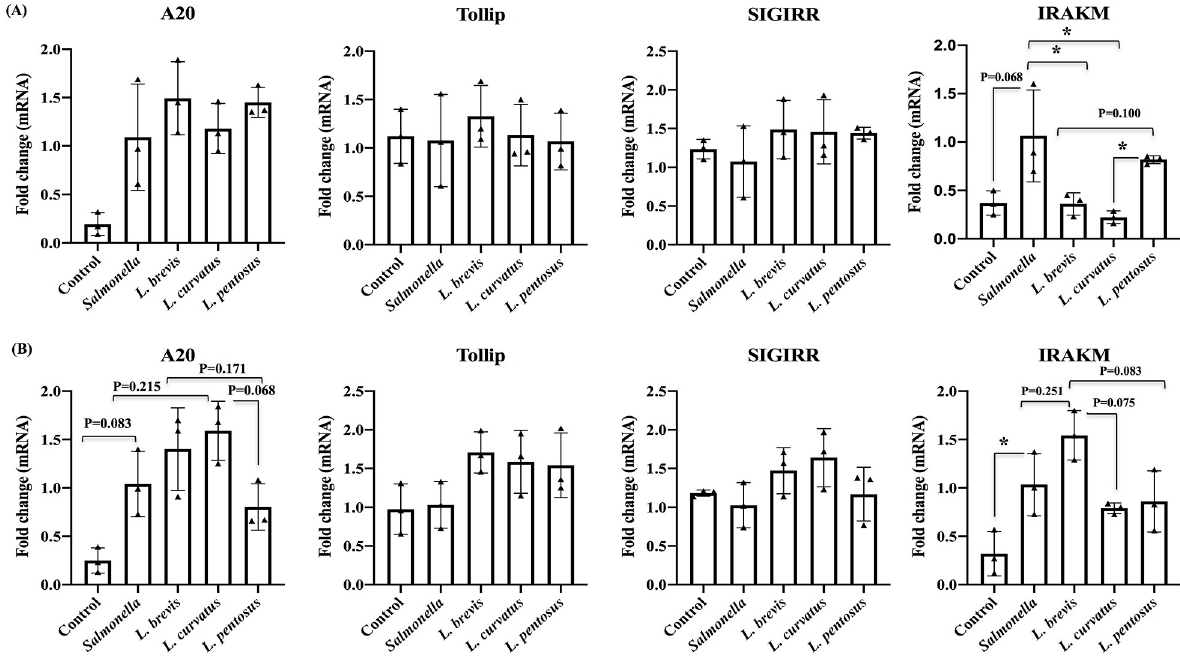
Fig 3. Lactobacillus strains modulate TLRs negative regulators expression in HT-29 cells. HT-29 cells were pre-stimulated with Lactobacillus strains (5 × 10 7 cells/ml) for 48 h and then post-stimulation with Salmonella for 3 (A) and 12 h (B). The mRNA level of A20, Tollip, SIGIRR and IRAK-M were analyzed by RT-PCR. HT-29 cells either with medium or Salmonella alone were used as controls. The results represented here is an average values (mean ± S.D) of three independent values. Significant differences between the groups, � p <